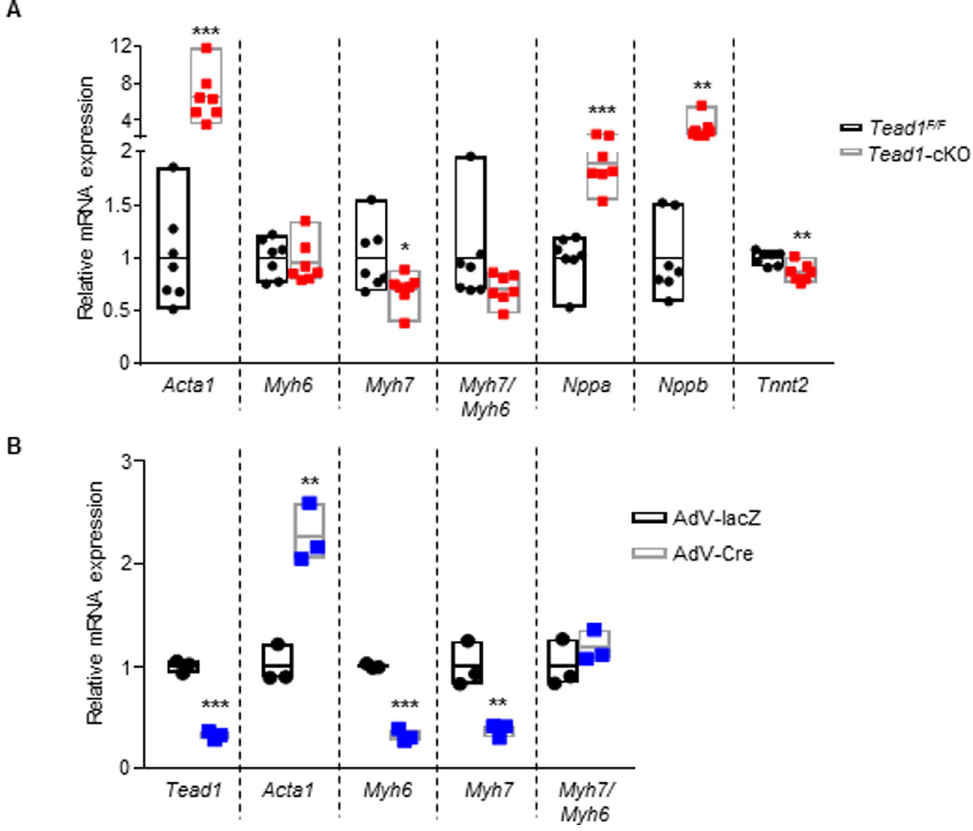
Fig 4. Tead1 deletion in perinatal cardiomyocytes leads to elevated markers of heart failure. Data are presented as mean ± s.e.m. ��� p < 0.001, �� p < 0.01, � p < 0.05; data were analyzed by Student’s t -test. Comparisons between ( A ) Tead1 -cKO pups and Tead F/F pups (n = 7), ( B ) Tead F/F neonatal cardiomyocytes transduced with adeno-virus Cre (Tead1 deletion) or lacZ